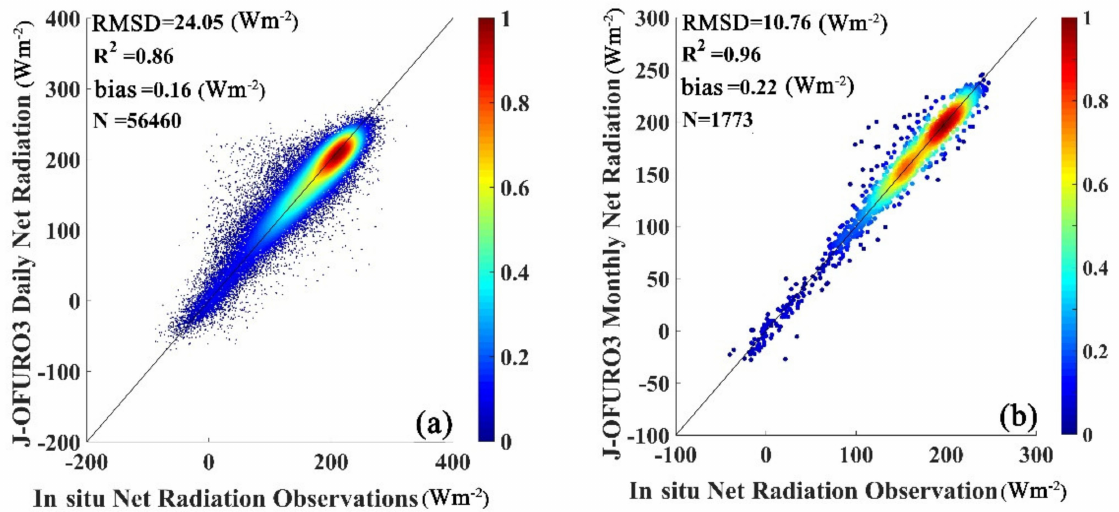
Figure 4. Scatter plots between the J-OFURO3 sea-surface R n data and the in situ measurements at ( a ) daily and ( b ) monthly